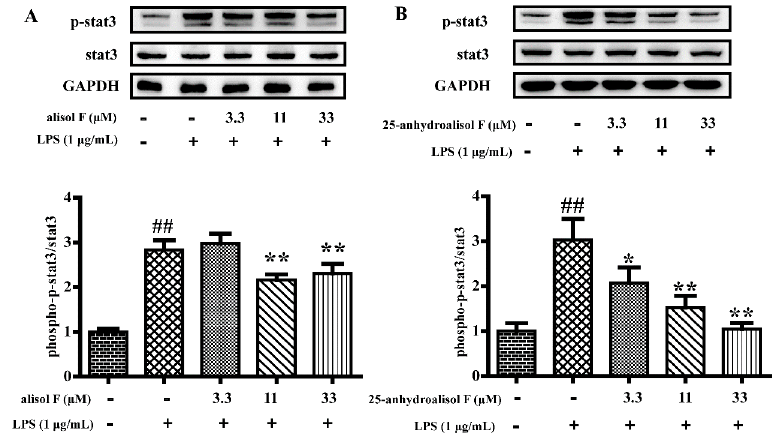
Figure 7. The effect of alisol F and 25-anhydroalisol F on LPS-induced activation of stat3 in RAW264.7 cells. Cells were pretreated with the different concentrations (0, 3.3, 11 and 33 μ M) and of alisol F ( A ) and 25-anhydroalisol F ( B ) for 2 h and then stimulated with or without LPS (1 μ g/mL) for 6 h. The expression of phospho-stat3 and stat3 proteins were analyzed by Western blot. The data represent the means ± S.E. of three independent experiments. ( ## p < 0.001 vs. control group; * p < 0.05, ** p < 0.001 vs. LPS group).